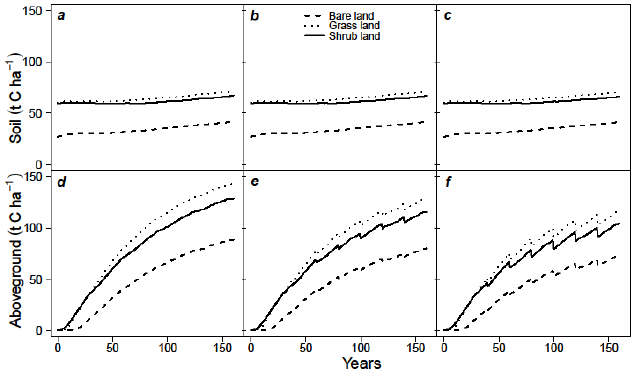
Figure 3. The simulated development of gross soil carbon ( a – c ) and gross aboveground carbon ( d – f ) over 150 years after reforestation under different management scenarios (unthinned = a , d ; thinning 1 = b , e ; and thinning 2 = c , f ), aggregated per land use type from all simulation points (Bare land n = 81, Grass land n = 135, Shrub land n = 160).